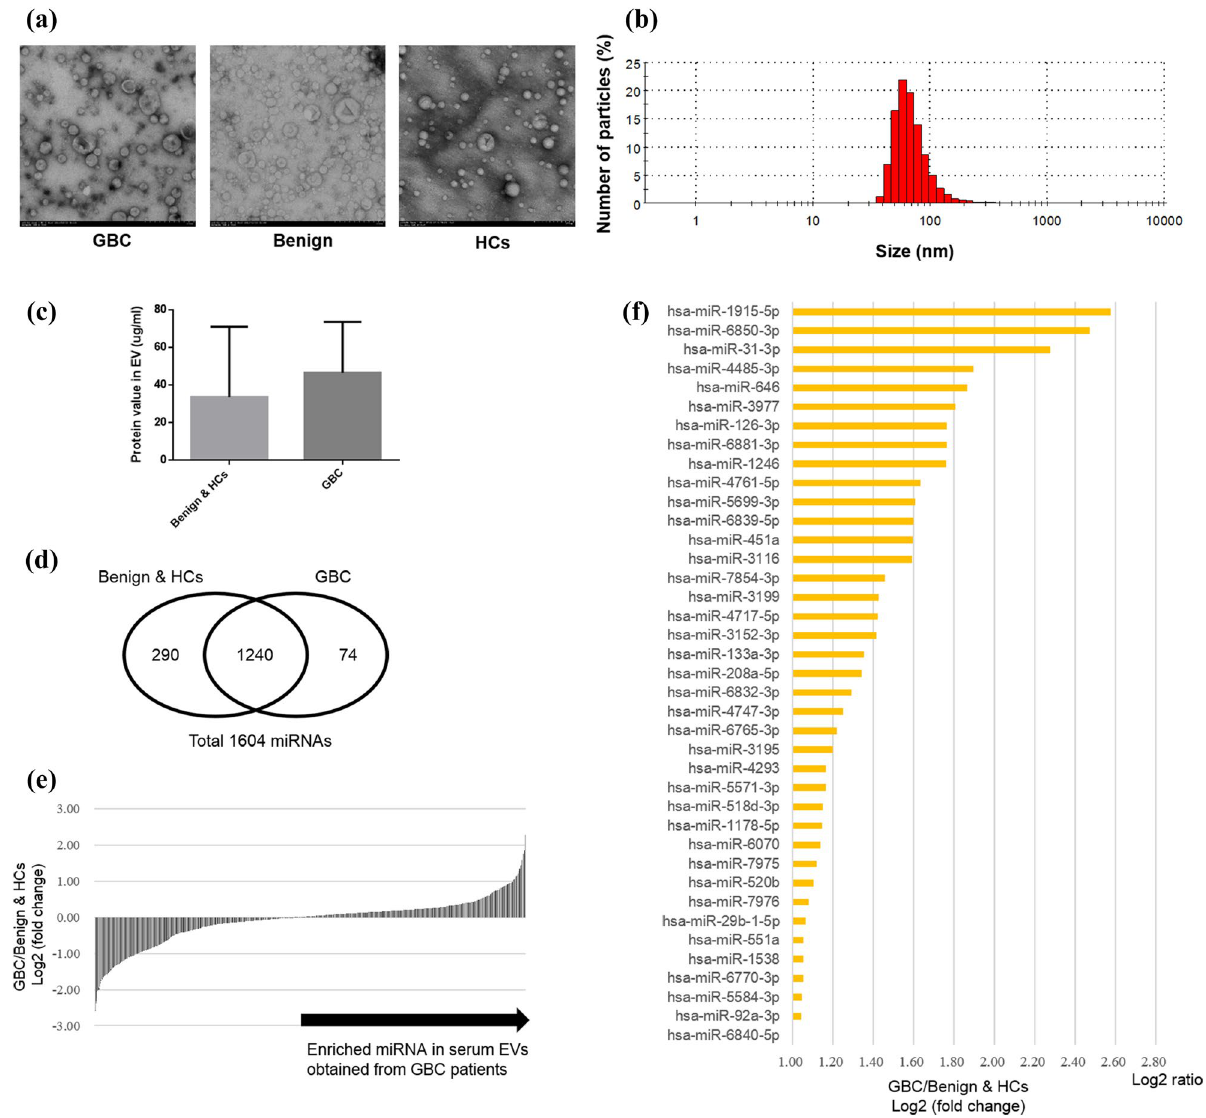
Figure 2. MicroRNA profiling of serum EVs obtained from the patients with gallbladder cancer and benign gallbladder disease, and healthy controls. ( a ) Serum EVs eluted in fraction #4 are observed as particles of 40–150 nm in size by transmission electron microscopy in all groups (× 25,000). Representative images of each group are presented. Scale bars represent 100 nm. GBC, gallbladder cancer; Benign, benign gallbladder disease; HCs, healthy controls. ( b ) The median size of isolated EVs measured by Zetasizer was 72 nm (range: 40–150). A representative image is shown. ( c ) The median protein concentration in #4 fraction was 46.6 μg/ml (IQR: 12.3–73.6) in the GBC (N = 50), and was 33.7 μg/ml (IQR: 19.4–71.0) in the Benign and the HCs (N = 69) (not significant). ( d ) The numbers of detected miRNAs in serum EVs isolated from the GBC and the combination of the Benign and the HCs is shown in a Venn diagram. ( e ) The fold change in the expression of each common 1240 miRNA in serum EVs in the GBC relative to the Benign and the HCs. ( f ) Thirty-nine miRNAs in serum EVs in the GBC showed a > twofold change relative to the Benign and the